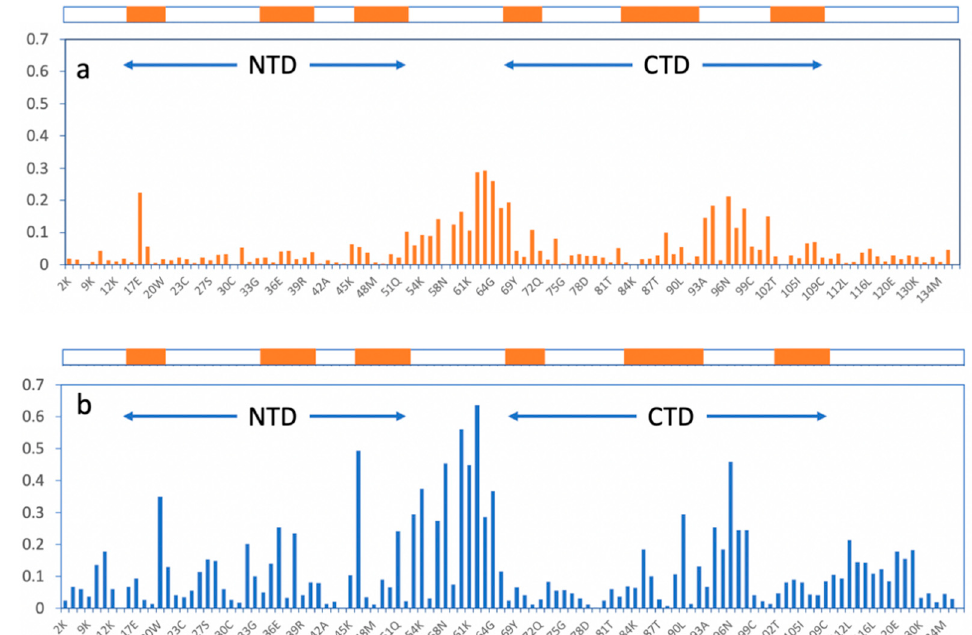
Figure 3. Graphical representation of chemical shift perturbation analysis per residue on PTN after addition of 1 ( a ) and 2 ( b ). Representation of beta-strand regions in NTD and CTD are shown on the top.